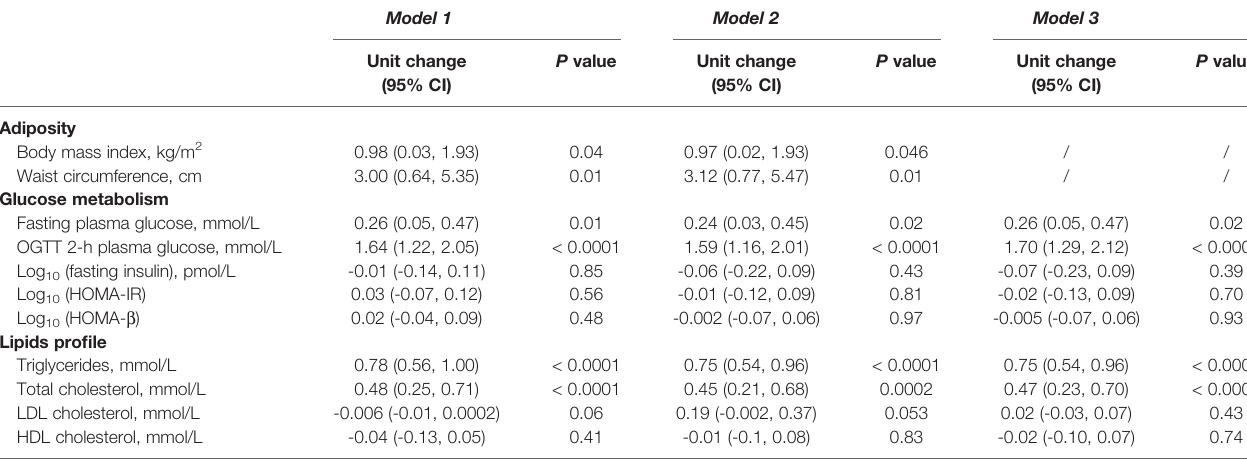
Table 3 shows the sex-speci fi c associations of serum RBP4 levels with adiposity indexes and glucolipid metabolism traits. Baseline serum RBP4 levels (indicated as each 1-unit of log 10 -RBP4)